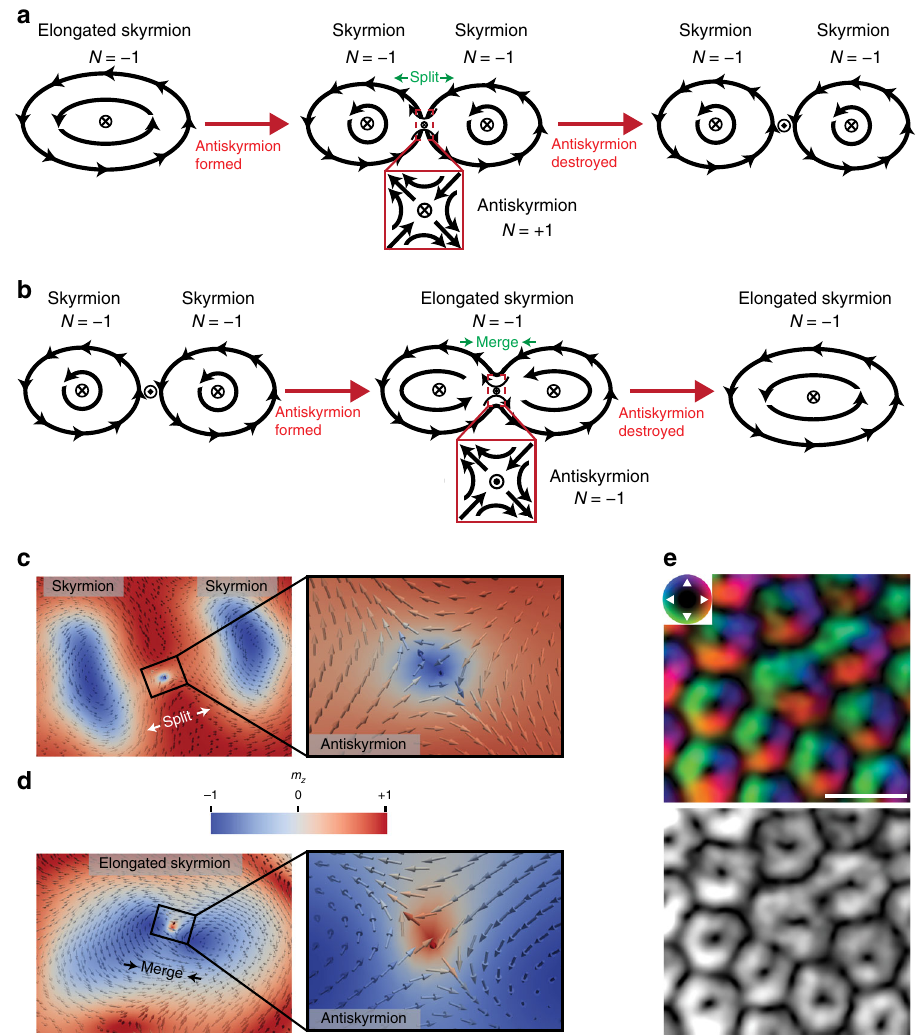
Fig. 4 Skyrmion creation and annihilation mechanisms and investigation of the deformed SkCoH structure. a , b Proposed mechanisms for skyrmion creation and annihilation via splitting and merging, respectively. N gives the topological charge of each structure involved. c , d Micromagnetic simulation snapshots of splitting and merging transition states, closely resembling the middle states in a , b , respectively. Colour bar indicates the out-of-plane ( m z ) component of magnetisation. e DPC images of a stationary 5 – 7 defect showing pronounced deformation of the SkCoH structure and indication of merging with nearest-neighbour skyrmions. Colour (top) is given by the inset colour wheel, which indicates the direction of the in-plane magnetisation, where black indicates out-of-plane magnetisation. Scale bar,